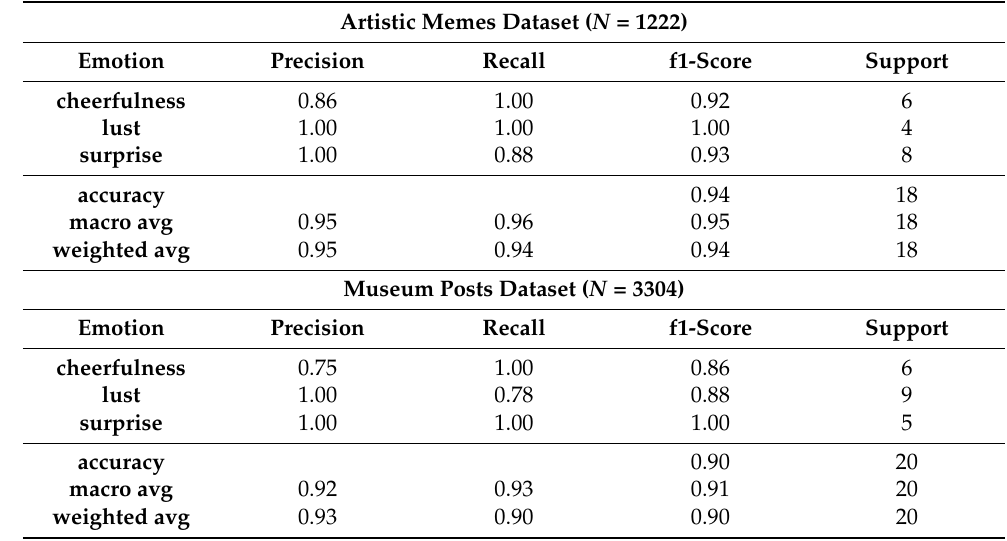
Table 4. Outcome evaluation by classification report. Correlation between likes, comments, nwords, and